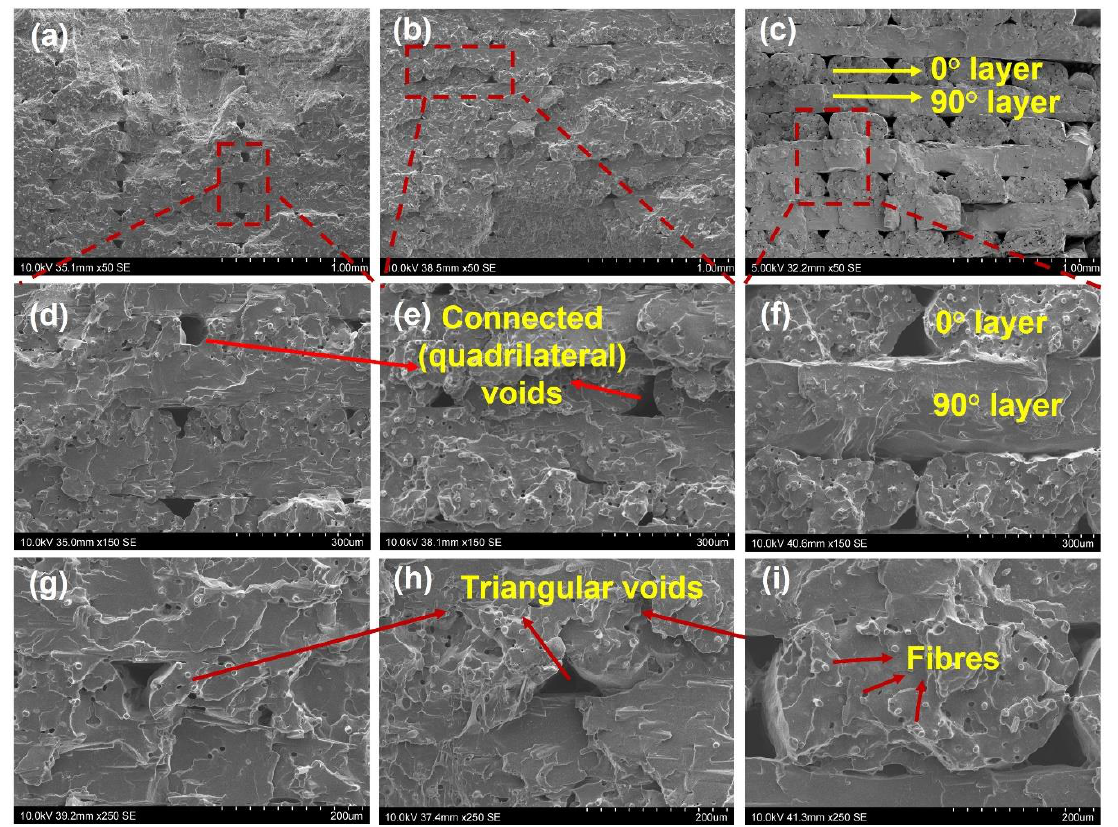
Figure 4. The structure of the printed [0, 90] composite samples with different layer thickness: 50×: ( a ) 0.1 mm, ( b ) 0.125 mm, ( c ) 0.2 mm; 150×: ( d ) 0.1 mm, ( e ) 0.125 mm, ( f ) 0.2 mm; 250×: ( g ) 0.1 mm, ( h ) 0.125 mm, ( i ) 0.2 mm.